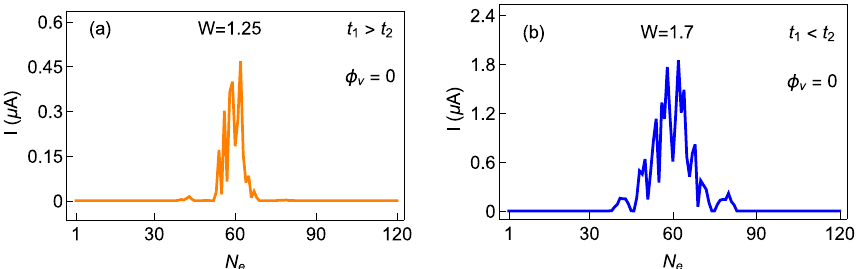
Figure 10. Absolute current as a function of total number of electrons N e at φ = 0.2 for ( a ) non-staggered and ( b ) staggered AAH SSH rings. Here we set N = 60 .